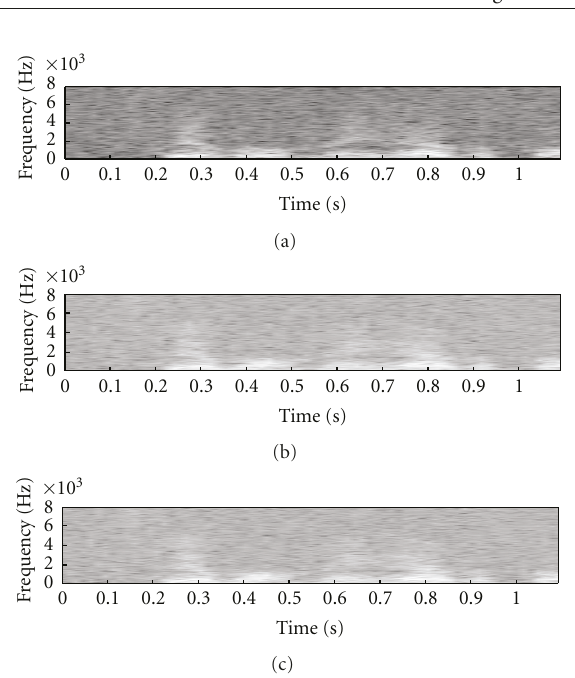
Figure 9: Spectrograms for a fragment of sentence SI648 from TIMIT corpus with additive white noise at 20dB SNR. Computed from the original signal (a), reconstructed from MFCC (b) and reconstructed from EFB-B4